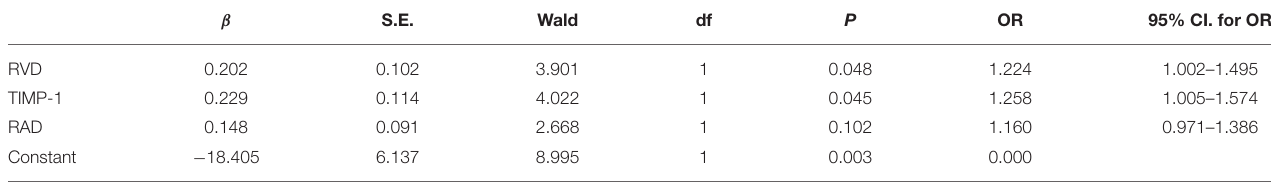
TABLE 3 | Factors for PH diagnosis among COPD patients based on logistic regression analysis. β S.E. Wald df P OR 95% CI. for OR